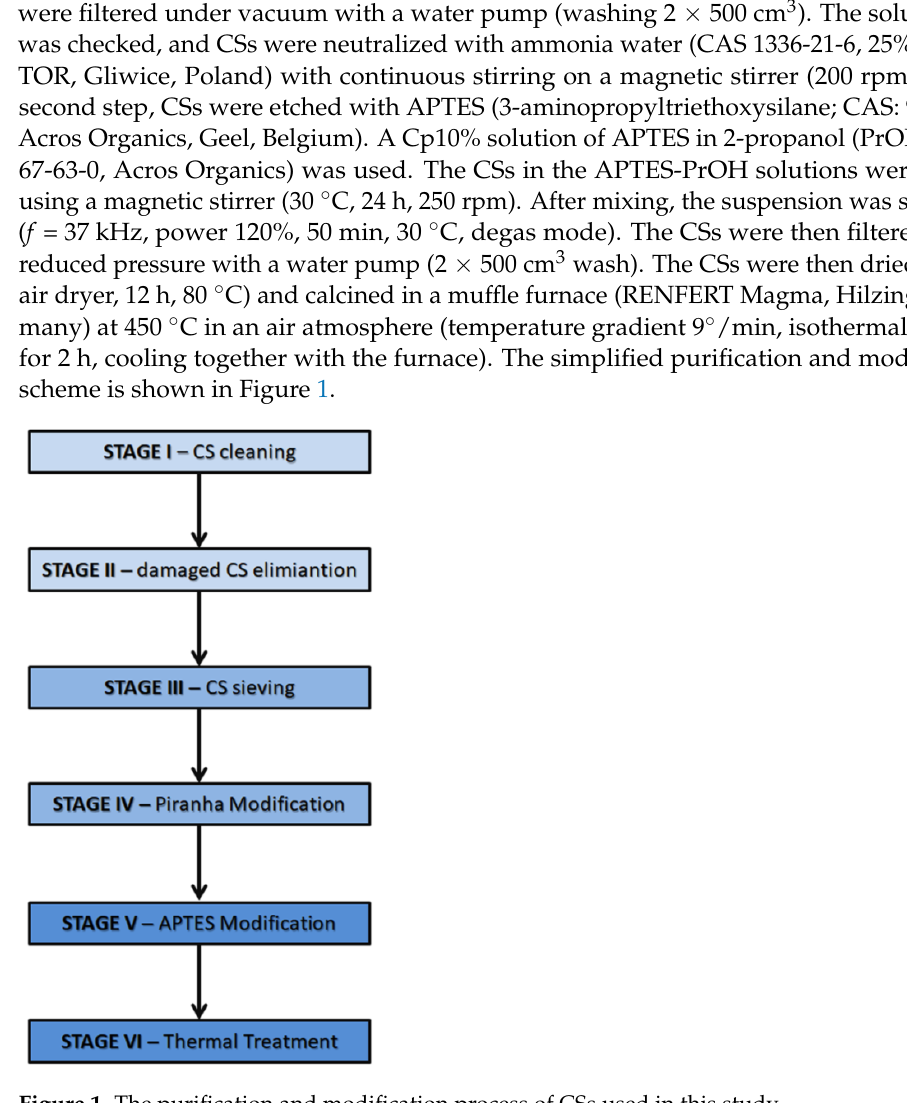
Figure 1. The purification and modification process of CSs used in this study.